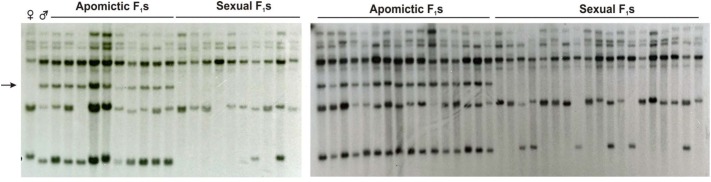
A-148-3 mapping onto the P. notatum genome by RFLP analysis. Hybridizing banding pattern of genomic DNA EcoRI digests of a P. notatum segregating population, composed of a female sexual parent (Q4188,♀), a male aposporous parent (Q4177, ♂) together with 29 sexual and 26 aposporous F1 plants. The arrow indicates a band inherited from the aposporous parent, which strictly co-segregates with apospory.